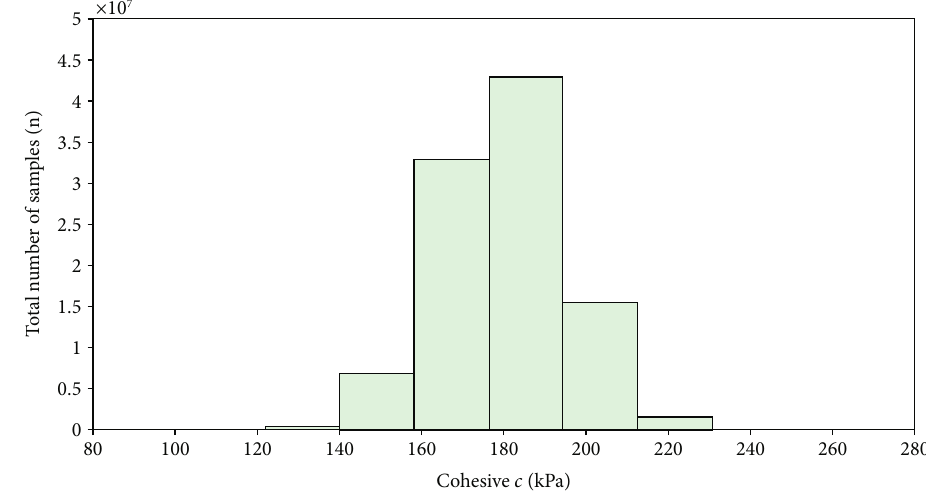
Figure 14: Statistical histogram of cohesion parameters.